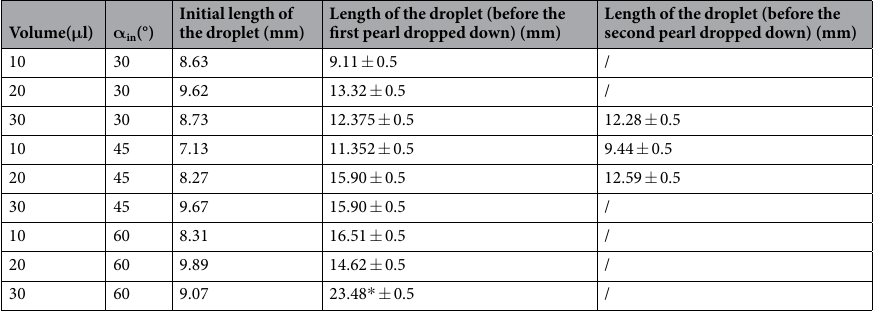
When the input power on the SPTs is immediately on, at this moment the velocities at liquid-solid interface are changing gradually except the positions around droplet’s advancing and receding ends 15 . Because of the inertia, pearls could be most probably left in the grooves (owing to surface roughness shown in Fig. 6) around the posi- tions of droplet’s advancing and receding ends of initial state. Meanwhile, it is generally observed that at the same inclination of substrate the receding angles decrease with increasing volumes of droplet; at the same volume of droplet the receding angles decrease with increasing